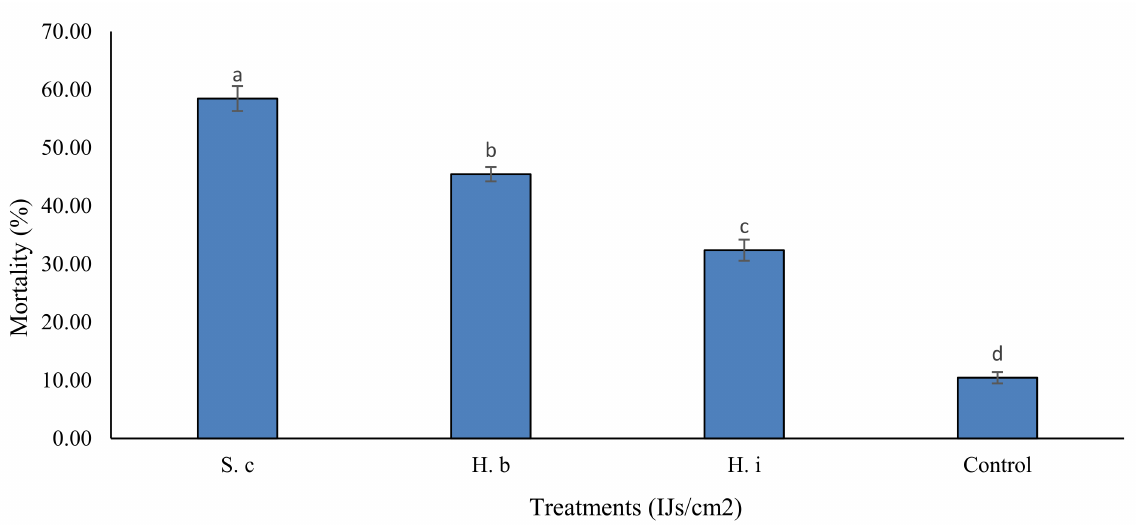
Figure 6. Effect of different nematodes on the control of Odontotermes obesus workers in field condi- tions. Bars with different lowercase letters were significantly different at p ≤ 0.05 (LSD test). Vertical bars indicate standard error (SE) values. S. c: Steinernema carpocapsae; H. b: Heterorhabditis bacteriophora; and H. i: Heterorhabditis indica. Treatments were applied at a dose rate of 1000 IJs/cm 2